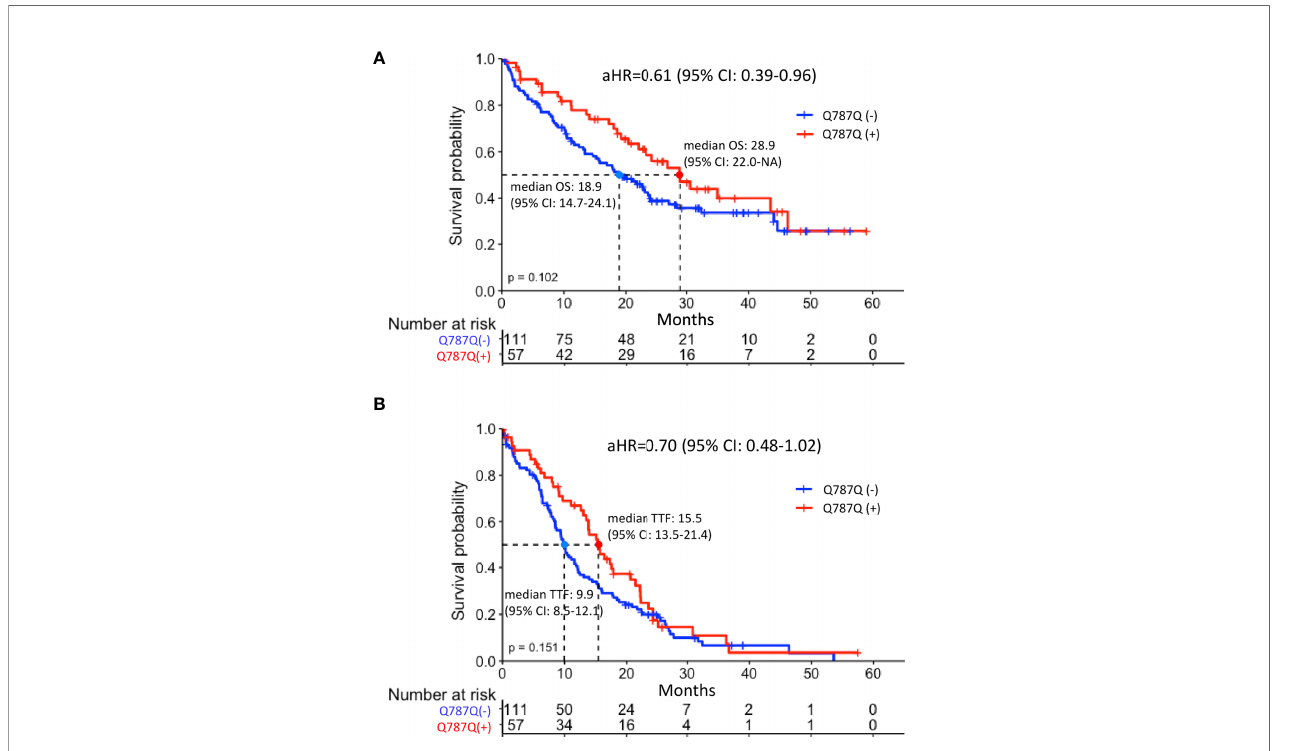
FIGURE 2 | Survival analysis of EGFRm-positive patients with or without EGFR Q787Q polymorphism treated with TKI (A) overall survival (B) Time to treatment failure. Median overall survival of the groups with and without EGFR Q787Q polymorphism were 28.8 months (95% CI: 22.0-NA) and 18.8 months (95% CI: 14.6- 24), respectively. Median time to treatment failure of the groups with and without EGFR Q787Q polymorphism groups were 15.5 months (95% CI: 13.5-21.4) and 9.9 months (95% CI: 8.5-12.1), respectively. Q787Q (+) and Q787Q ( – ) denoted patients with EGFR Q787Q polymorphism and without EGFR Q787Q polymorphism,